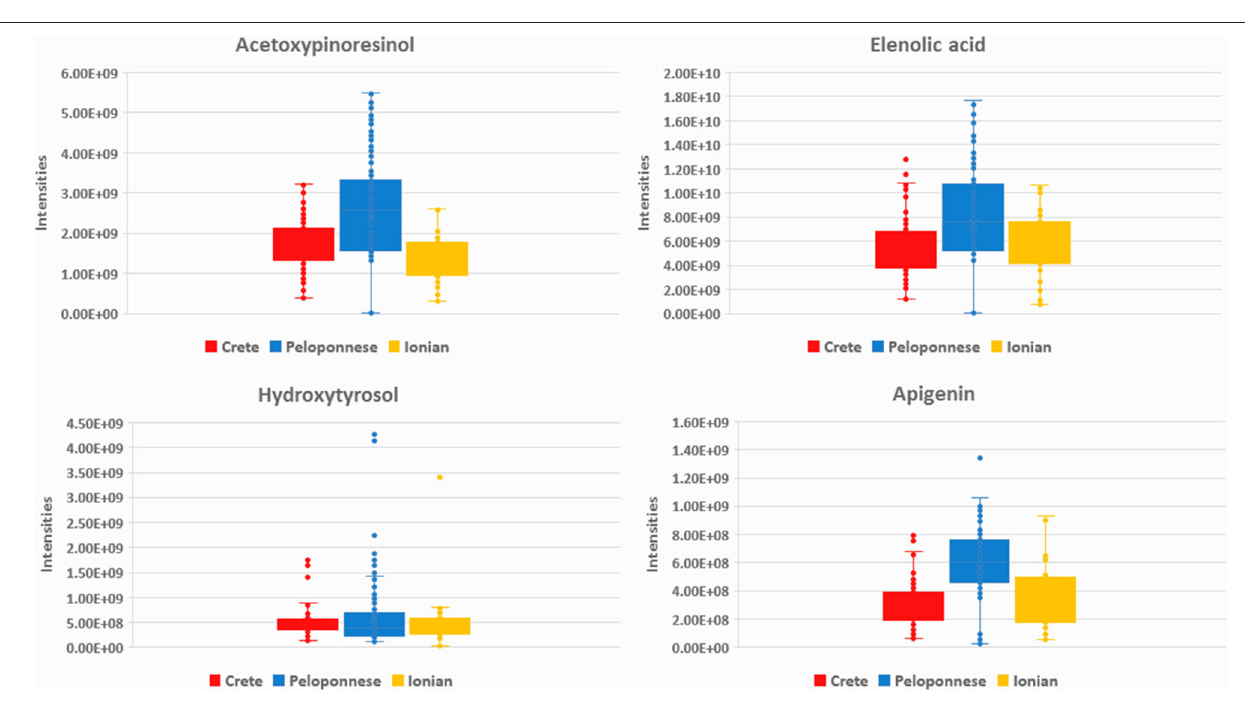
Frontiers in Public Health |